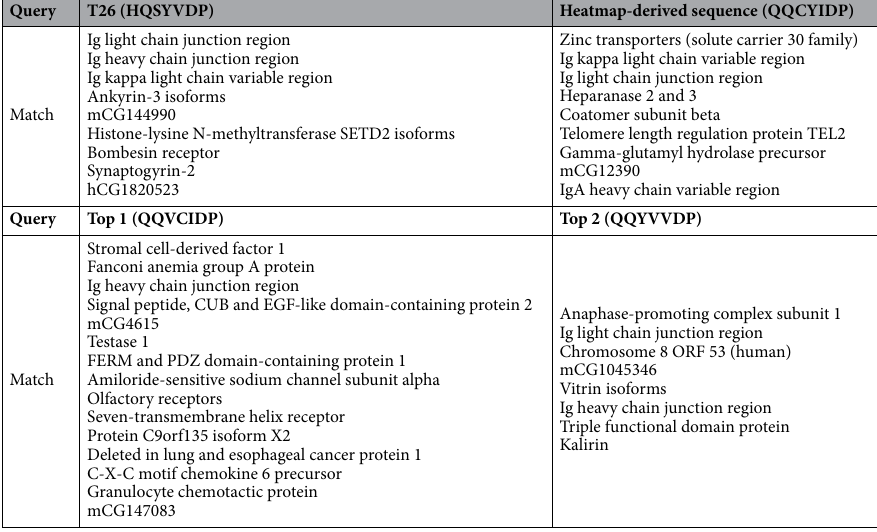
Table 1. Summarized results of the Blastp search with four query sequences, consisting of the first 7 a.a. residues of the peptides against the human and mouse proteins. Only the matches with 6–7 residues including one residue mismatch, or 5 residues without a mismatch are given. If aligned amino acid residues are not identical but are similar in size and nature, this was not considered a